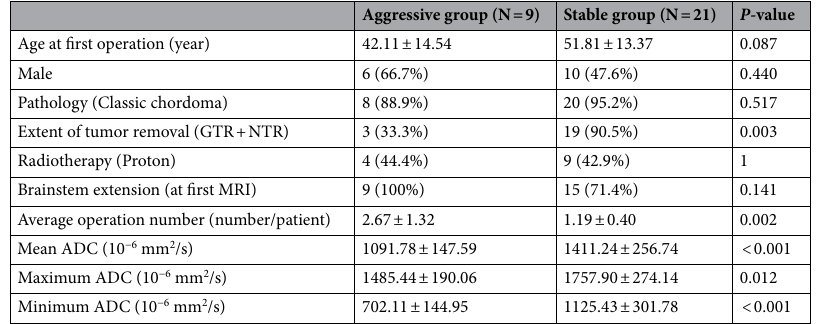
Table 1. Case demographics and clinical characteristics. ADC apparent diffusion coefficient, GTR gross total resection, MRI magnetic resonance imaging, NTR near total resection, SD standard deviation. Variables are presented as mean ± standard deviation or number